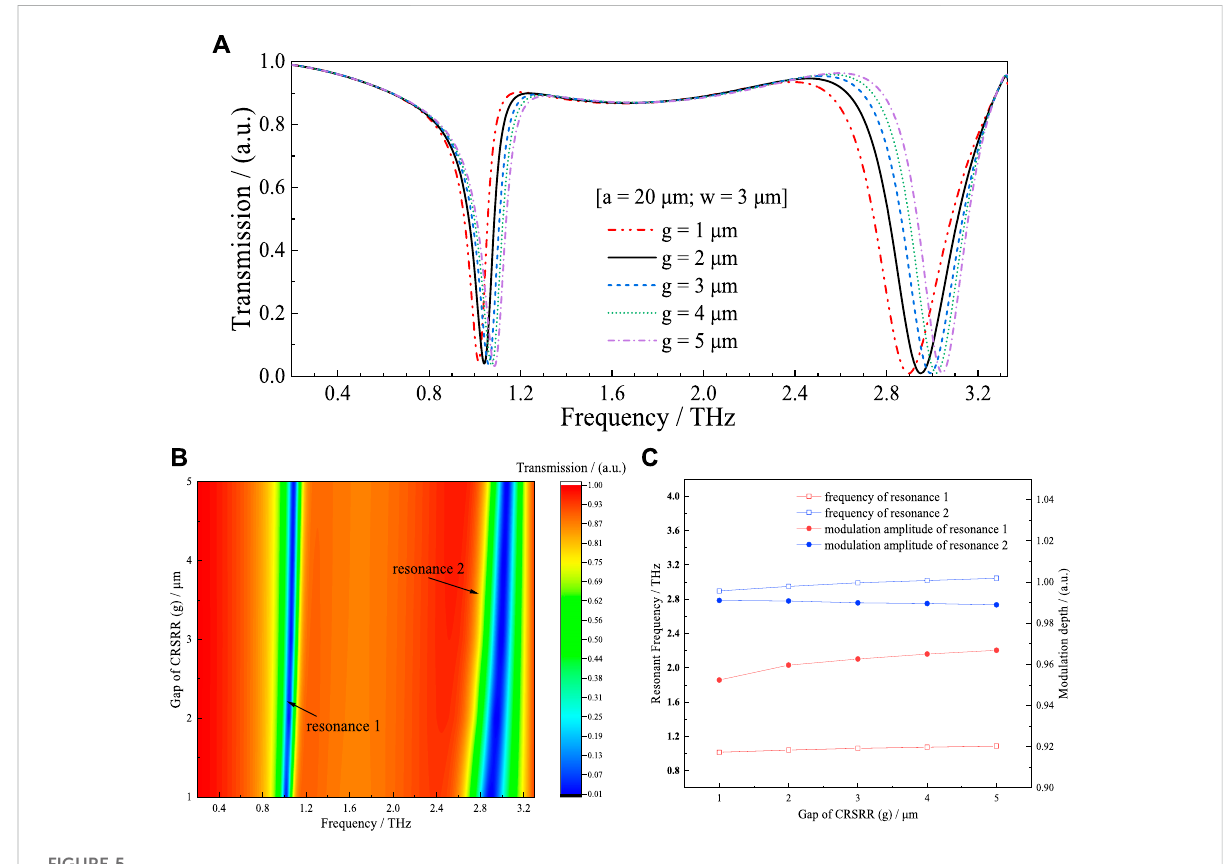
FIGURE 5 (A) The transmission spectra of the proposed MM with varying g from 1 to 5 μ m (the changing step is 1 μ m); (B) Contour plot of numerically simulated transmittance for different g ; (C) The relations between resonant frequencies (modulation depths) and the value of g